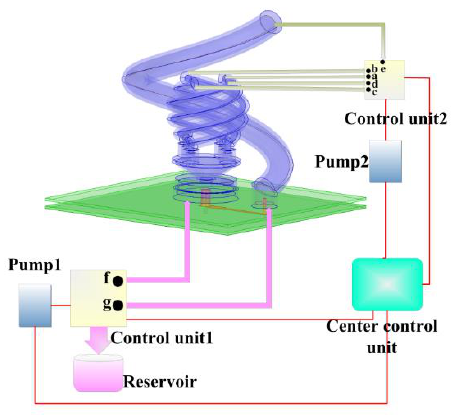
Figure 26. The abridged general view for dynamic control of the liquid metal.